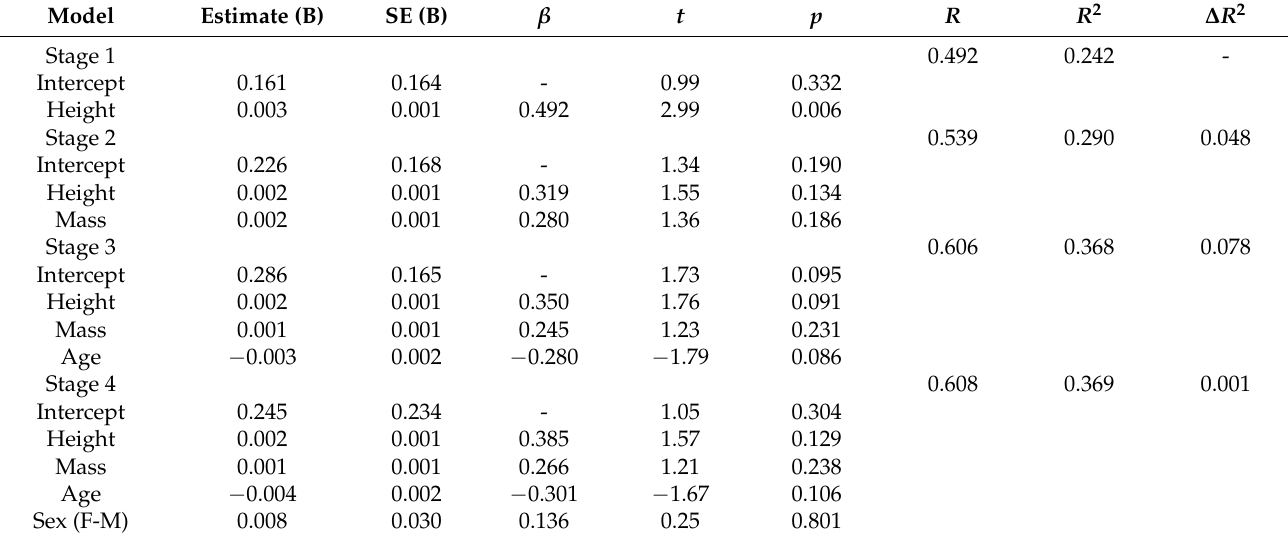
Table 4. Regression results for stance